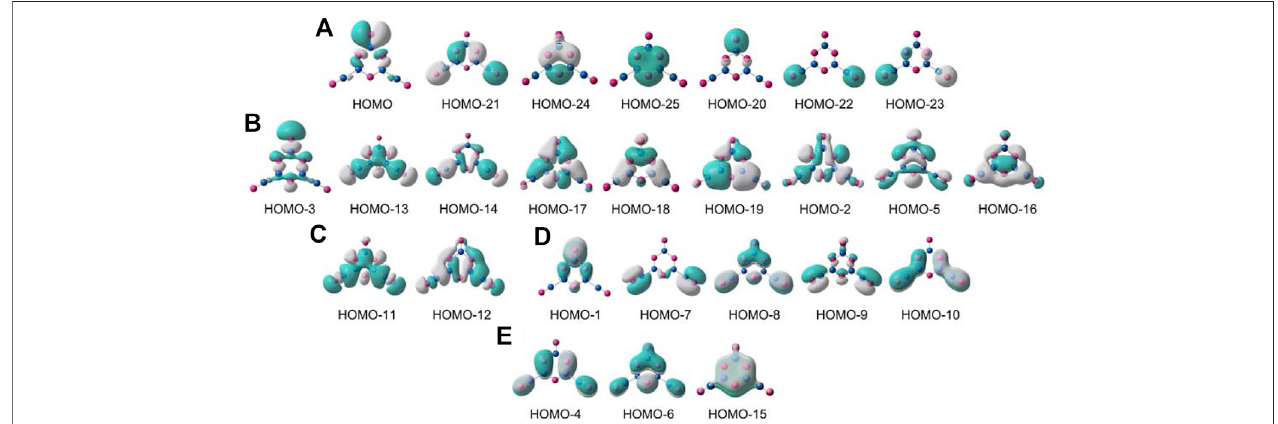
FIGURE 7 | Pictures of occupied canonical molecular orbitals (CMOs) of B 5 O 6 − (1) cluster. (A) Seven lone pairs for the O atoms, including two for the upper O site. (B) Nine σ CMOs for Lewis-type skeleton and terminal B − O σ bonds. (C) Two σ CMOs for Lewis-type B − B σ single bonds. (D) Five CMOs for both in-plane and out-of- plane π bonds relevant to terminal B − O units. (E) Three delocalized π CMOs over the B 3 O 3